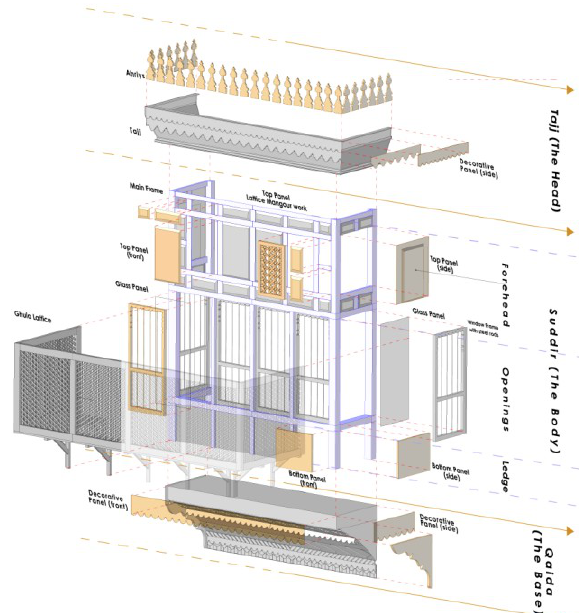
Figure 3.Exploded view of the Roshan’s parts and components.